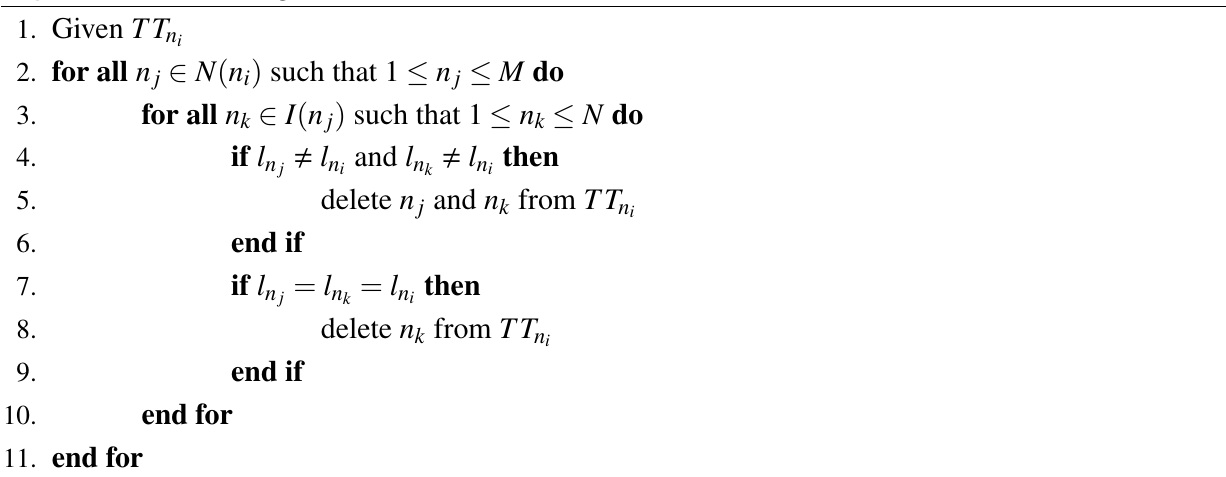
Algorithm 1 Interfering-receiver table construction of node n